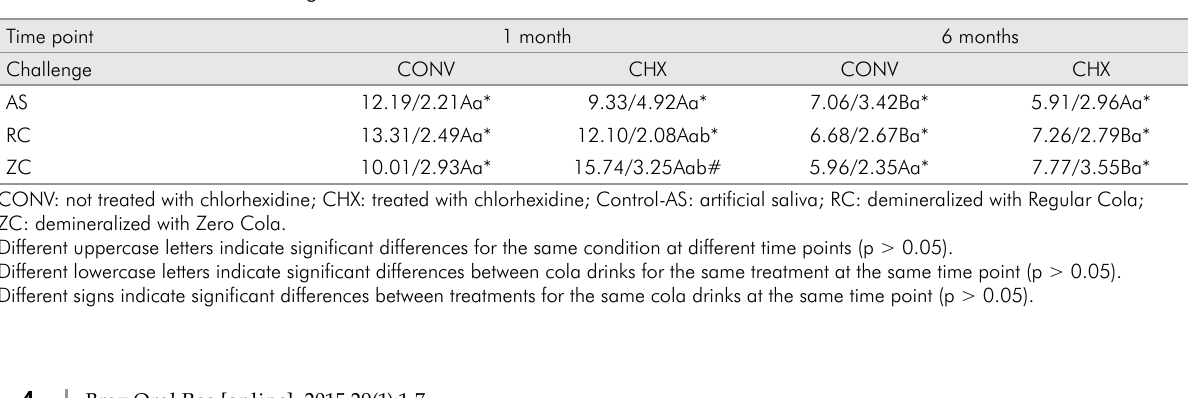
Table 2. Microshear bond strength mean values in